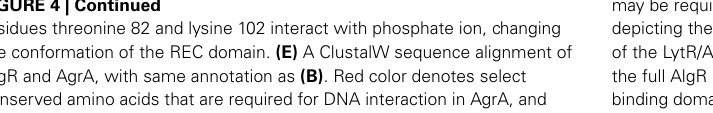
FIGURE 4 | Continued residues threonine 82 and lysine 102 interact with phosphate ion, changing the conformation of the REC domain. (E) A ClustalW sequence alignment of AlgR and AgrA, with same annotation as (B) . Red color denotes select conserved amino acids that are required for DNA interaction in AgrA, and